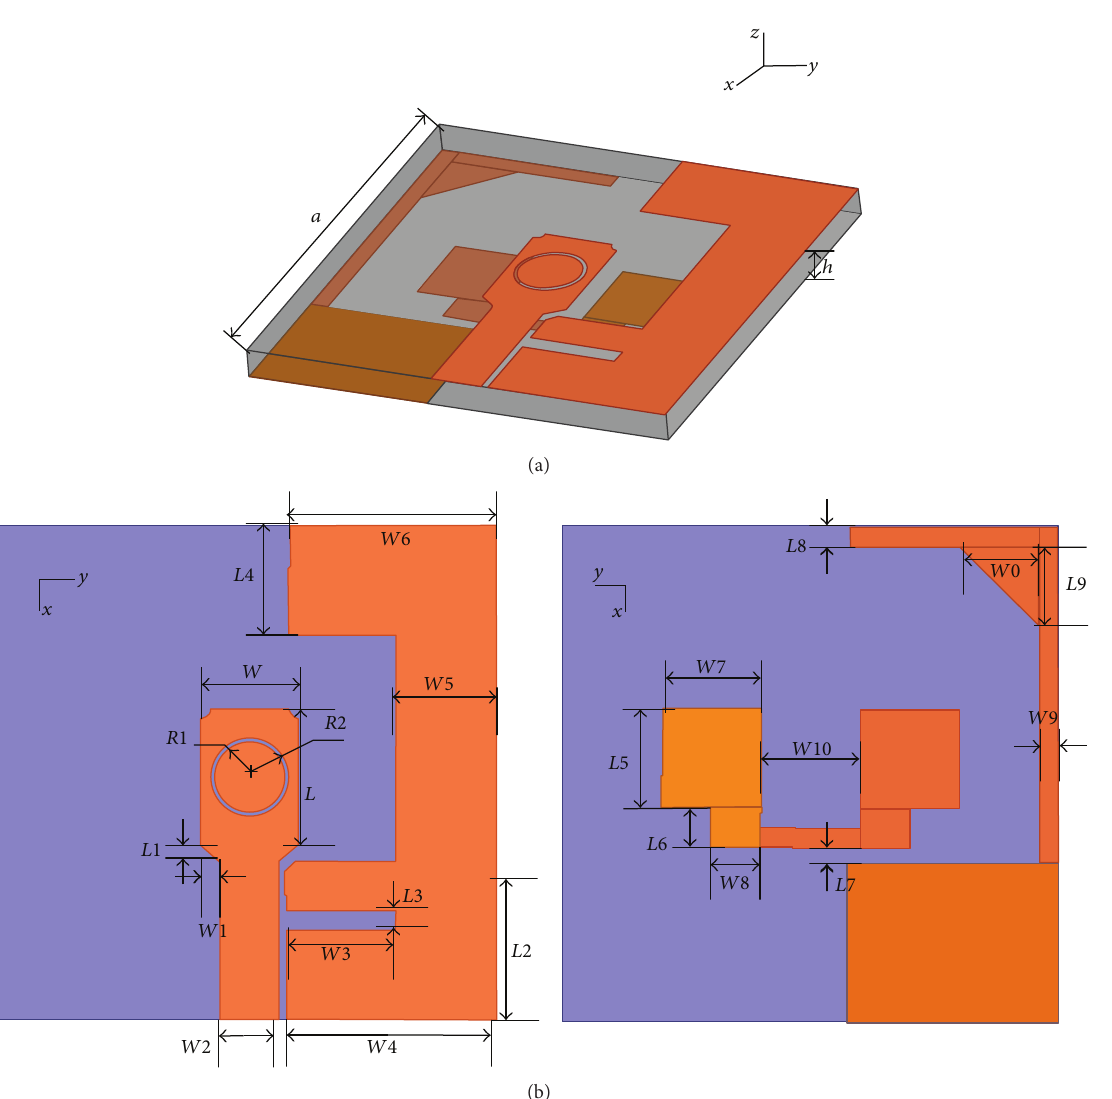
Figure 1: Geometry of the proposed antenna: (a) side view and (b) top view (left) and bottom view (right).